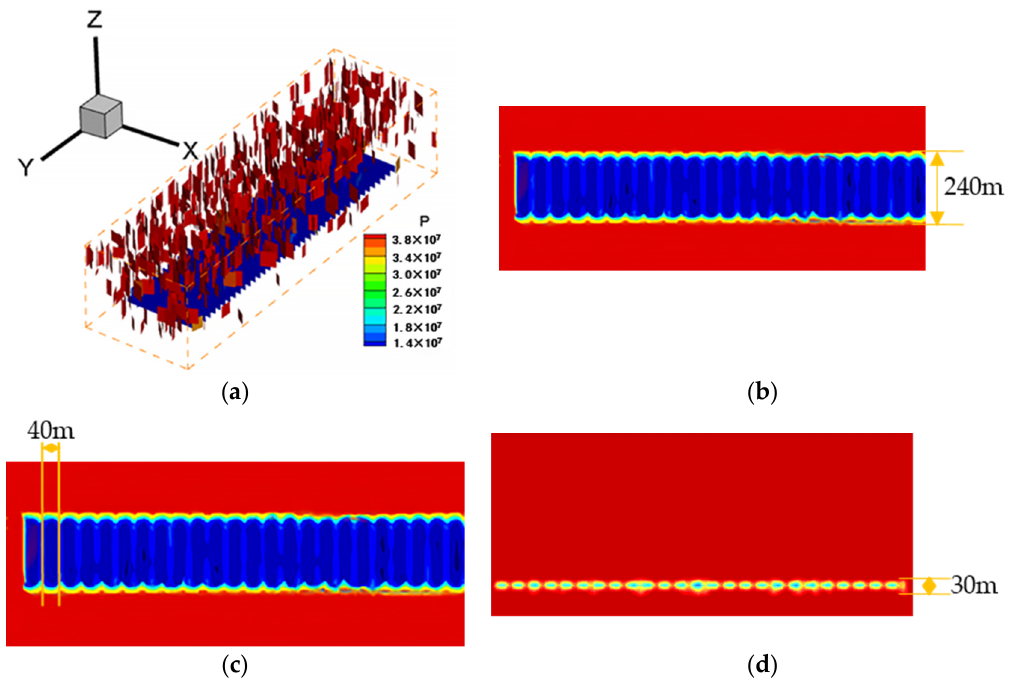
Figure 7. Pressure changes and reservoir utilization range after 15 years of low-density (0.001 m/m 2 ) natural fracture reservoir exploitation: ( a ) Pressure field diagram; ( b ) Utilization range in X direction; ( c ) Utilization range in Y direction; ( d ) Utilization range in Z direction.